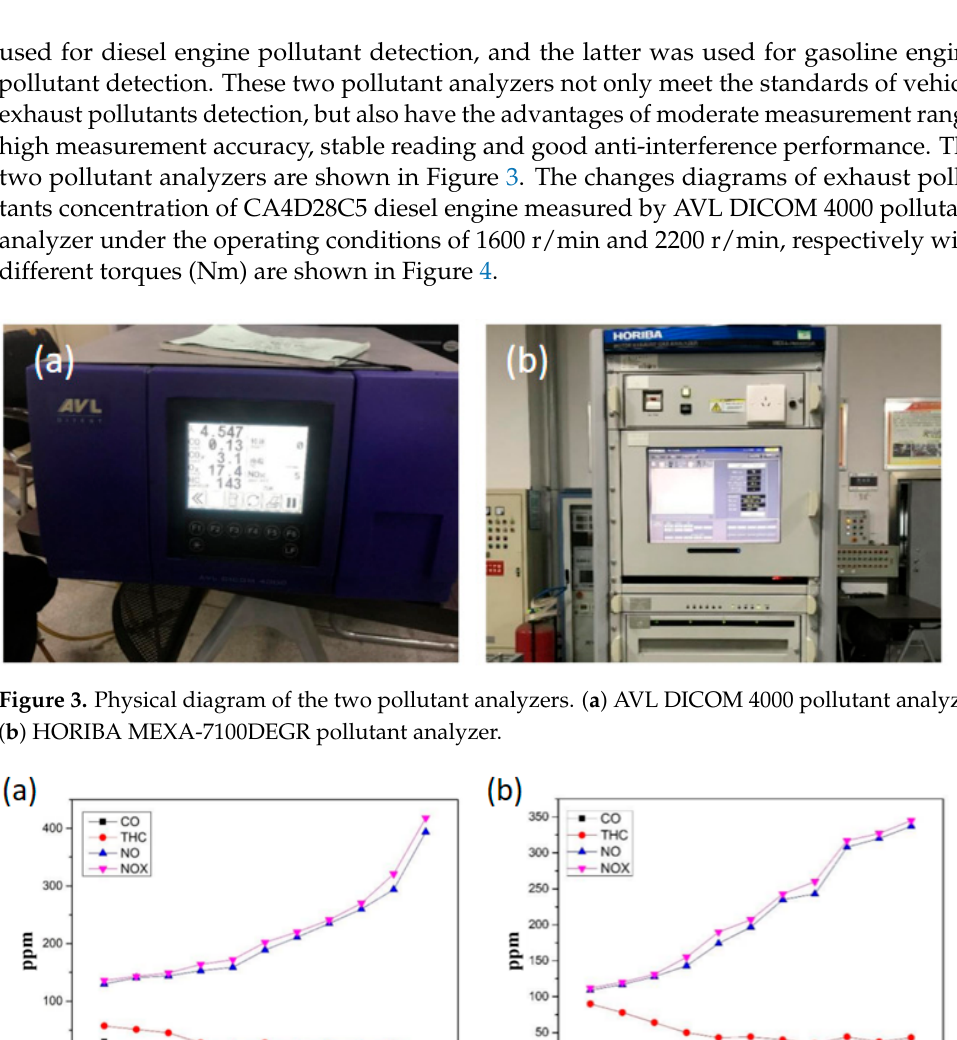
Figure 4. Exhaust pollutants concentration diagrams of CA4D28C5 diesel engine under different torques (Nm) with different rotary speeds conditions. ( a ) Variation in exhaust pollutants concentration under different torques (Nm) with 1600 r/min. ( b ) Variation in exhaust pollutants concentration under different torques (Nm) with 2200 r/min.